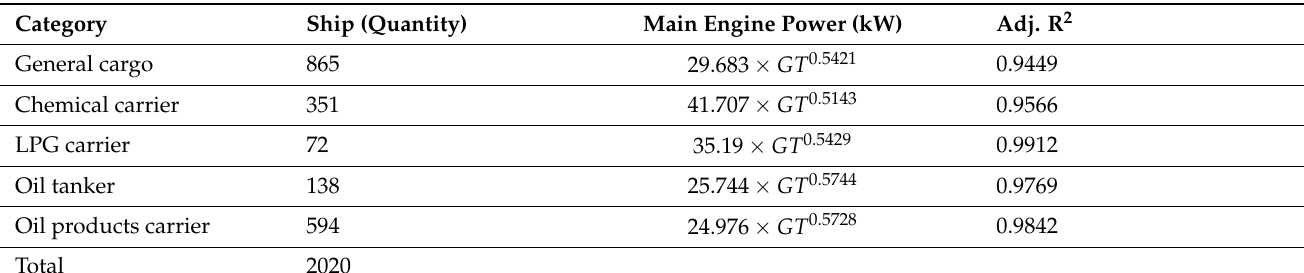
Figure 5. Non − linear regression of M/E power and GT of general cargo ( a ); LPG carrier ( b ); oil tanker ( c ); chemical tanker ( d ); and oil product carrier ( e ). Table 6. Correlation results of regressions between M/E Power and GT.